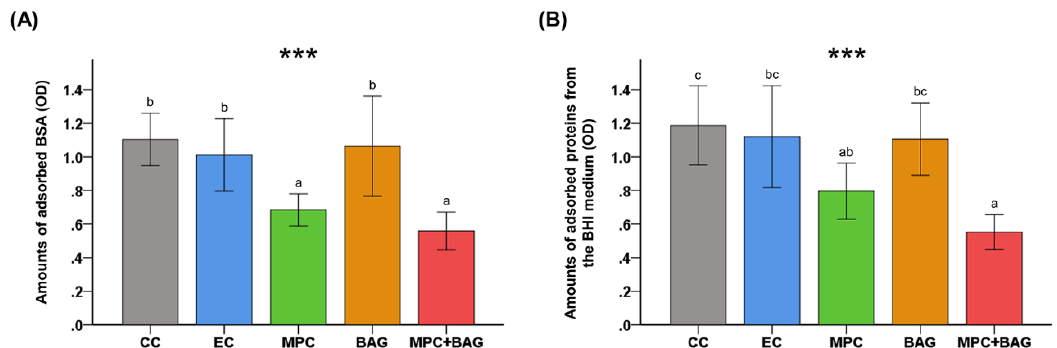
Figure 3. Comparison of the optical density (OD) of adsorbed bovine serum albumin (BSA) ( A ) and protein adsorbed form brain heart infusion (BHI) ( B ) between different groups: Commercial control (CC), experimental control of 50 wt% resin matrix + 50 wt% glass filler (EC), 48.5 wt% resin matrix + 48.5 wt% glass filler + 3 wt% MPC (MPC), 50 wt% resin matrix + 37.5 wt% glass filler + 12.5 wt% BAG (BAG), and 48.5 wt% resin matrix + 36.38 wt% glass filler + 12.12 wt% BAG + 3 wt% MPC (MPC+BAG).